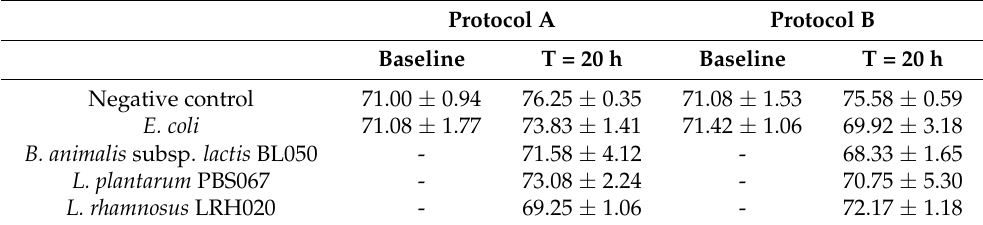
Table 4. Trans-Epithelial-Electrical-Resistance (TEER) expressed in Ohm × cm 2 at baseline (only in the controls), at the end of the colonization with E. coli , and at the end of treatment with probiotics (20 h).